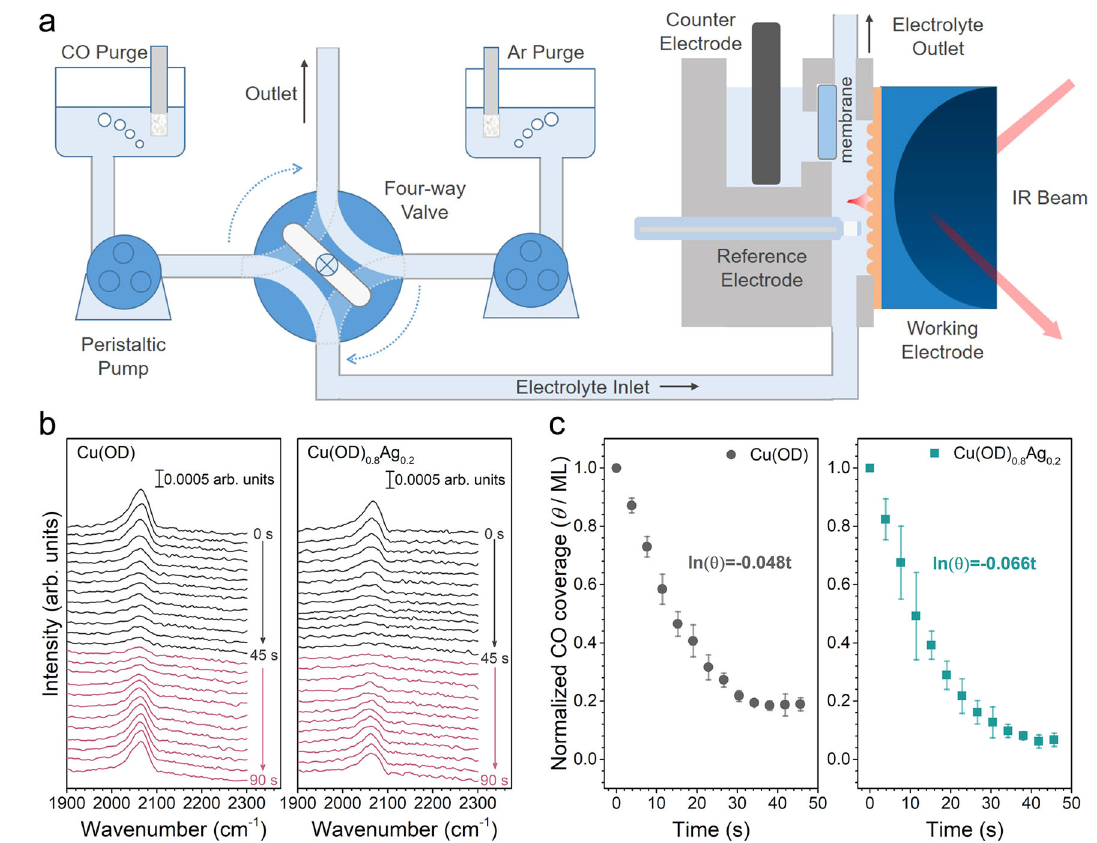
Fig. 2 | Desorption rate of CO ad measured by surface-enhanced infrared absorptionspectroscopy.a Schematicofthecustom-designedtwo-compartment micro fl uidic fl ow electrochemical spectroscopic cell. b Representative time evo- lutionoftheinfraredbandsthatresultfromCOboundtoCusurfacerecordedafter